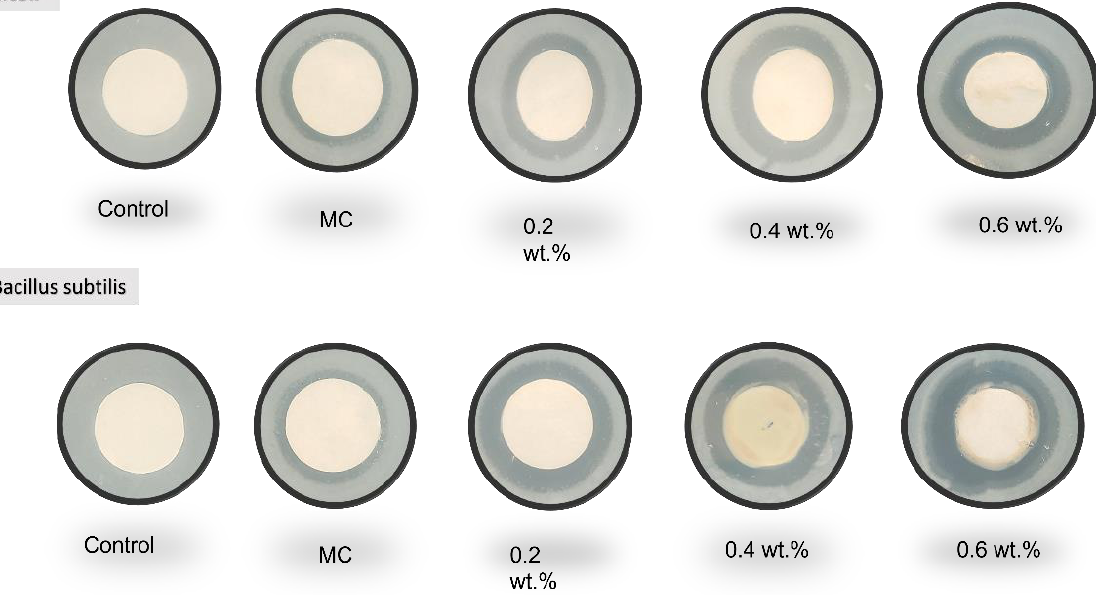
Figure 8. Disk diffusion test of PVA/MC (CuO 0.0%), PVA/MC/CuO 0.2 wt.%, PVA/MC/CuO 0.4 wt.%, and PVA/MC/CuO 0.6 wt.%. nanofibers.